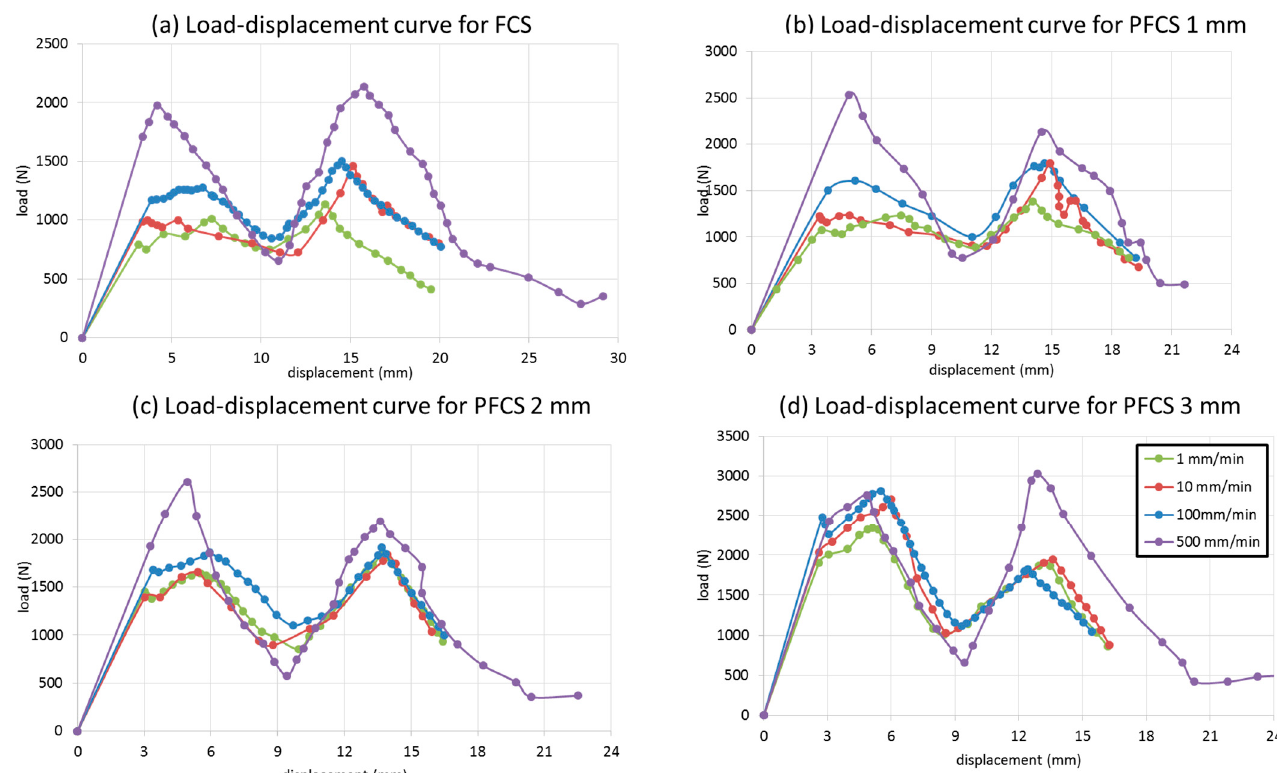
Figure 11. FE results for ( a ) FCS, ( b ) 1 mm PFCS, ( c ) 2 mm PFCS, ( d ) 3 mm PFCS panels under different loading rates.